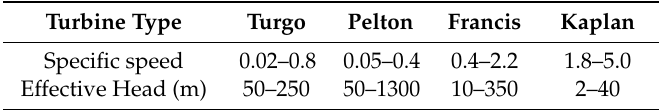
Table 5. Operating ranges of hydraulic turbines; Dixon and Hall [19].